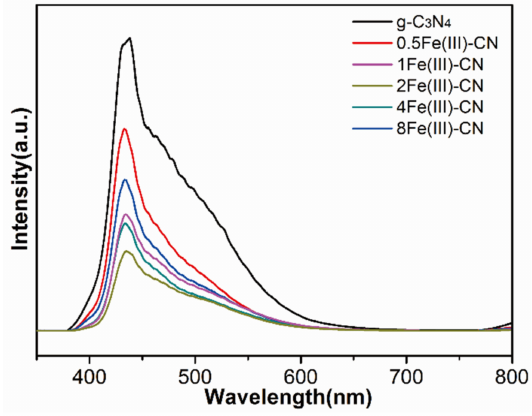
Figure 8. PL spectra of all samples.